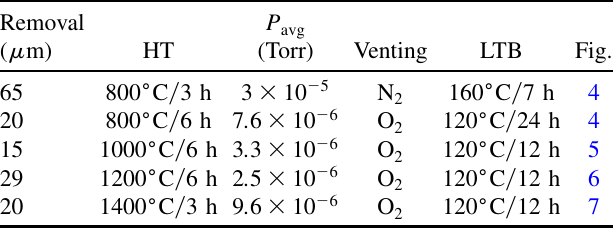
vs B p results. 0